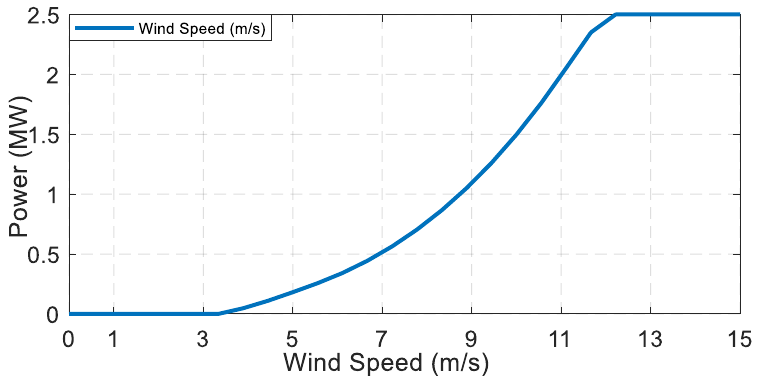
Figure 11. Power curve of the DFIG.